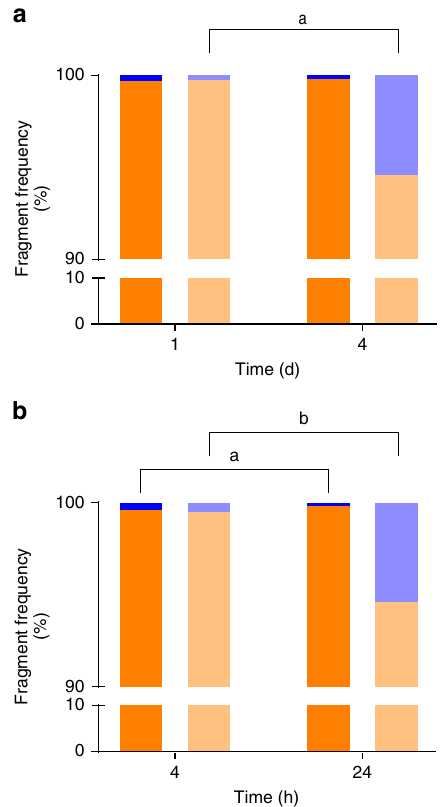
Fig. 2 Proportions of egested fragmented and whole beads over time. Frequency of whole (blue) and fragmented (orange) particles isolated from faecal pellets of Antarctic krill exposed to Low (20%; n = 3 beakers) (dark) and high (80%; n = 3 beakers) (light) concentrations at: a 24 h on Day 1 ( n = 6) and Day 4 ( n = 6), b 4 ( n = 6) and 24 h ( n = 6) on Day 4 only. All faecal material per beaker (containing fi ve krill) was pooled to form a single sample per time point per dose. Letters denote statistically signi fi cance differences in the proportion of whole beads excreted over time ( p < 0.05, X 2